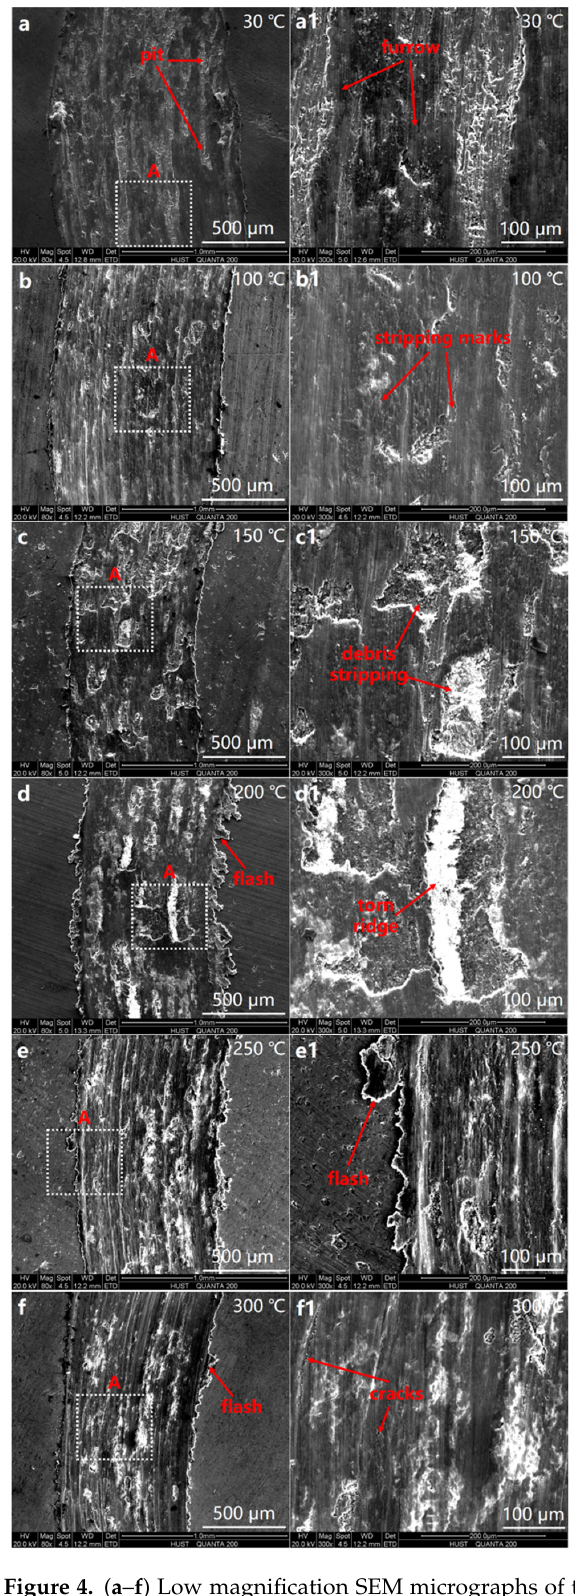
Figure 4. ( a – f ) Low magnification SEM micrographs of the microstructure of the wear surface at 30 °C, 100 °C, 150 °C, 200 °C, 250 °C and 300 °C; ( a1 – f1 ) High magnification SEM micrographs of the structure of area A in a–f.